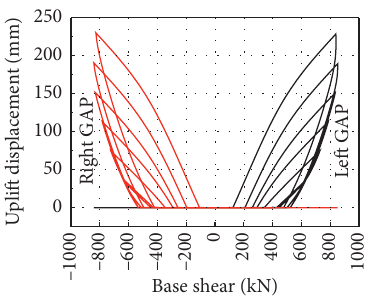
Figure 16: Curve of uplift displacement versus base shear of GAP.